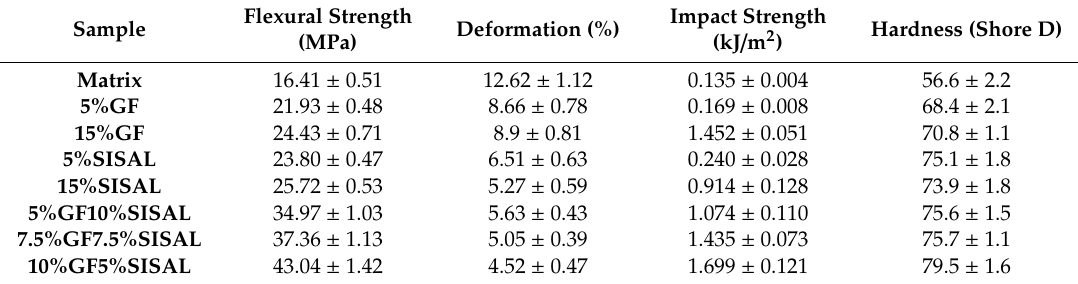
Table 2. Mechanical properties of obtained